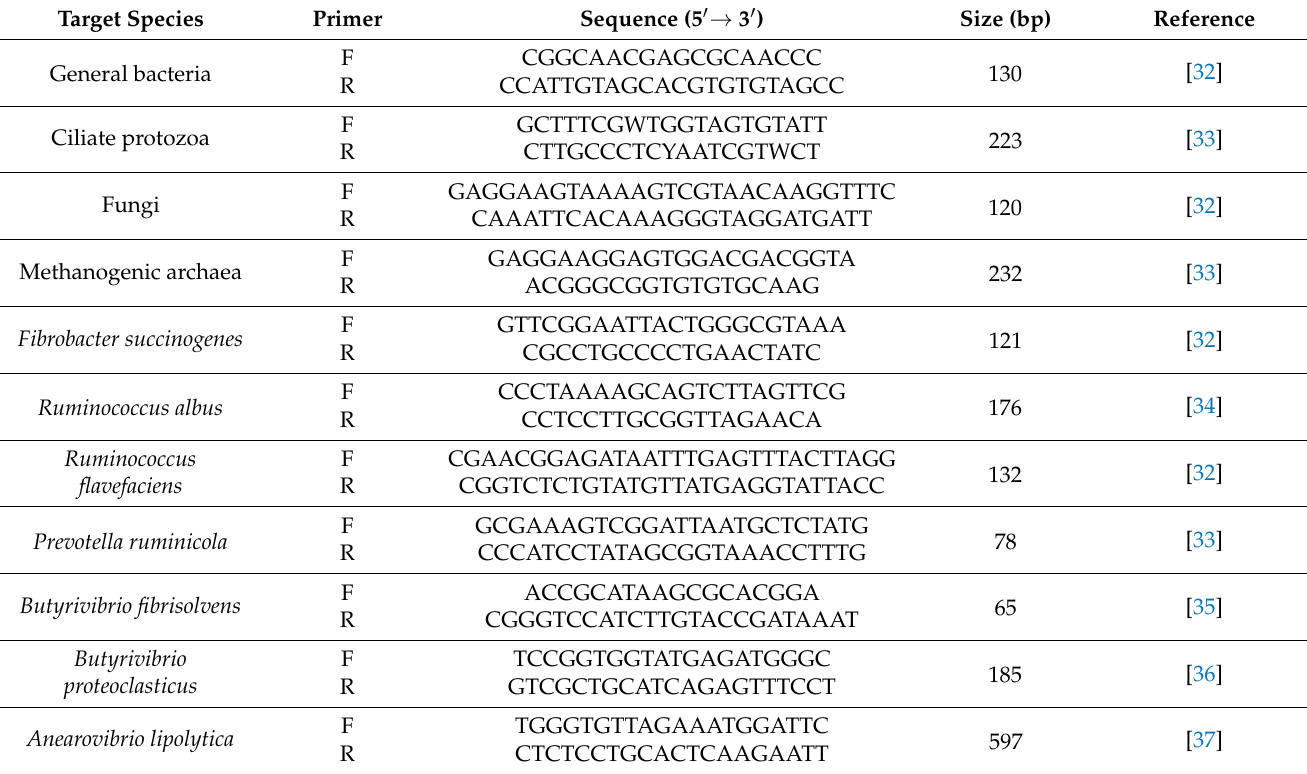
Table 1. Polymerase chain reaction primer for quantitative real-time polymerase chain reaction assays. Target